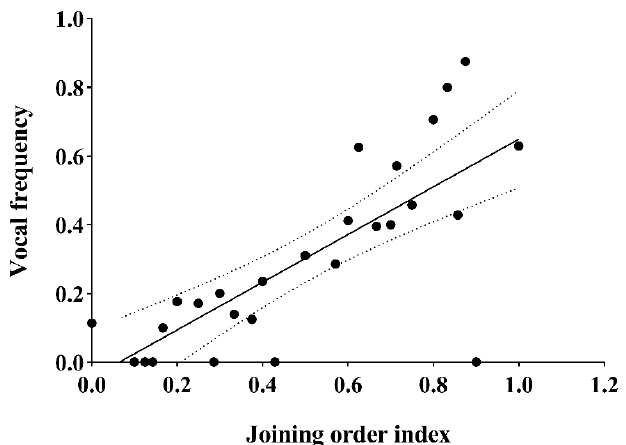
Figure 3. The correlation between the joining order index and vocal frequency during collective movements. The horizontal axis represents the joining orders of individuals: the higher the index, the earlier the individual joins the movement. The vertical axis represents the vocal frequency of individuals. The larger the vocal frequency, the more frequently the individual vocalizes.